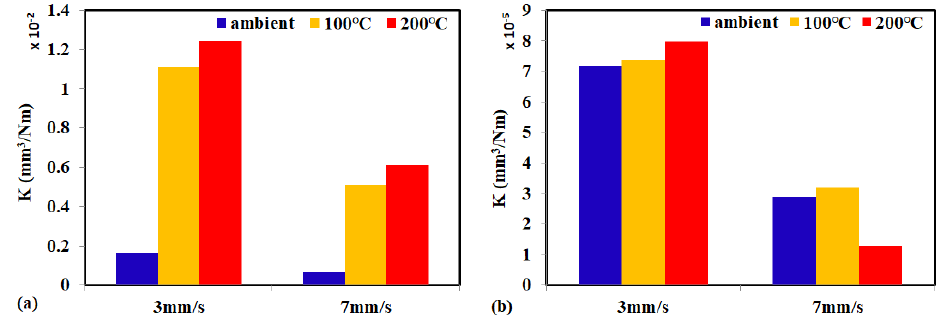
Figure 7. Wear coefficient of ( a ) crystalline Pd and ( b ) amorphous Pd alloy samples at different temperatures.